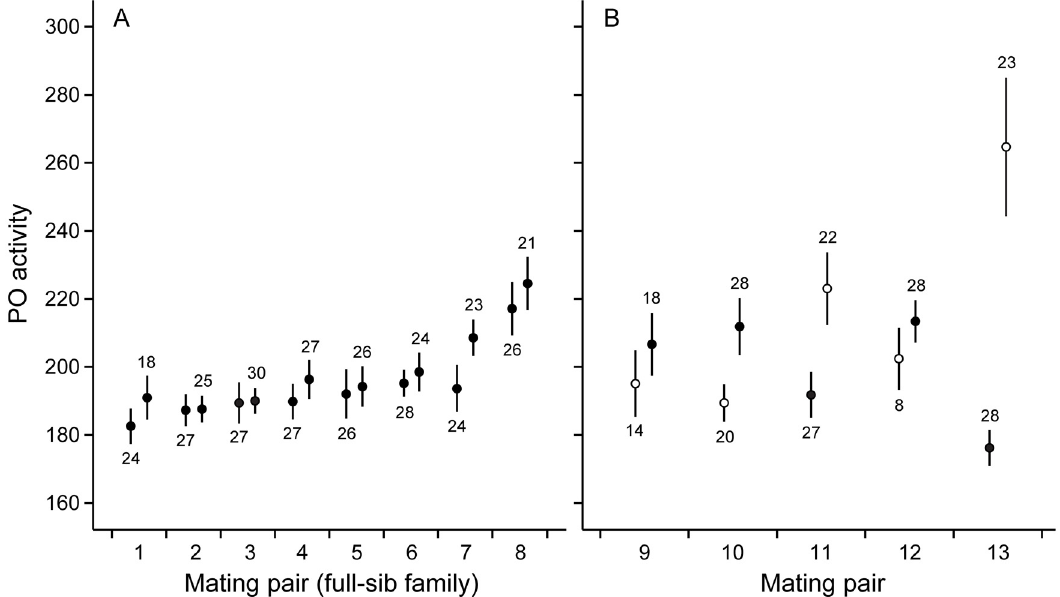
Fig 1. Phenoloxidase (PO) activity (change in optical density over the course of 6 h measured in milliunits) in snail hemolymph. (A) Mean ( ± SE) of individuals produced by different dams in mating pairs of parental snails in which both dams reproduced through outcrossing (individuals produced by each pair are full-sibs). (B) Mean ( ± SE) of individuals produced by different dams in mating pairs in which one dam reproduced through self-fertilization (open circles).